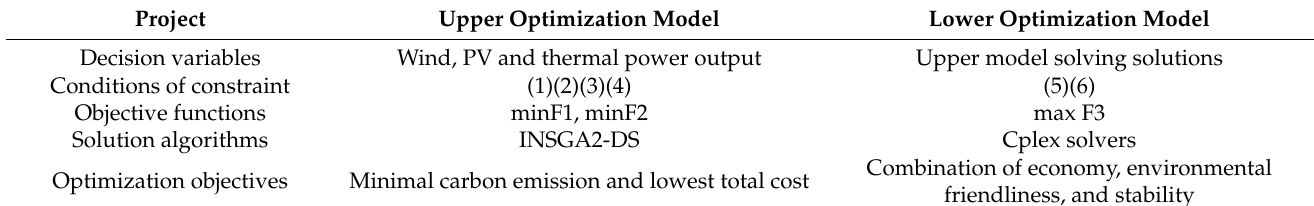
Table 1. Bi-level model for optimal system capacity planning.